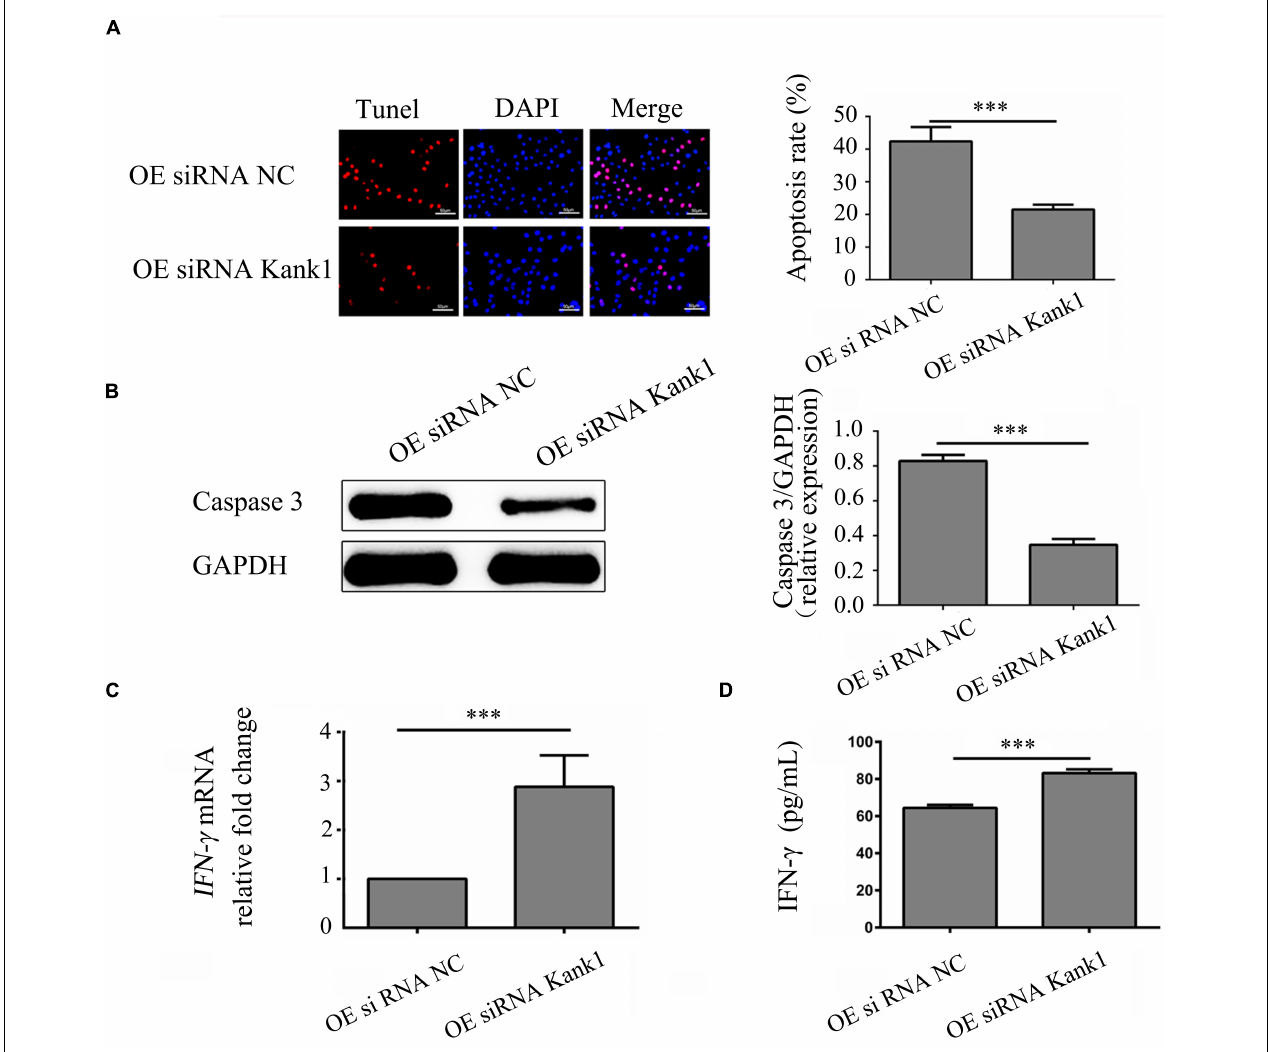
FIGURE 5 | LncRNA-ENST00000421645 promoted apoptosis and inhibited the secretion of IFN- γ through Kank1 in T lymphocytes. (A) Apoptosis was detected in OEsiRNA NC cells and OEsiRNA Kank1 cells with a TUNEL apoptosis detection kit. (B) The protein level of caspase3 in OEsiRNA NC cells and OEsiRNA Kank1 cells was determined by Western blot analysis. (C) The relative fold change in IFN- γ mRNA expression in OEsiRNA NC cells and OEsiRNA Kank1 cells was determined by RT-qPCR. (D) The IFN- γ protein concentration in OEsiRNA NC cells and OEsiRNA Kank1 cells was measured by ELISA ( ∗∗∗ P < 0.001). Student’s t -test was used for comparisons between two groups. Two-tailed P -values less than 0.05 were considered statistically